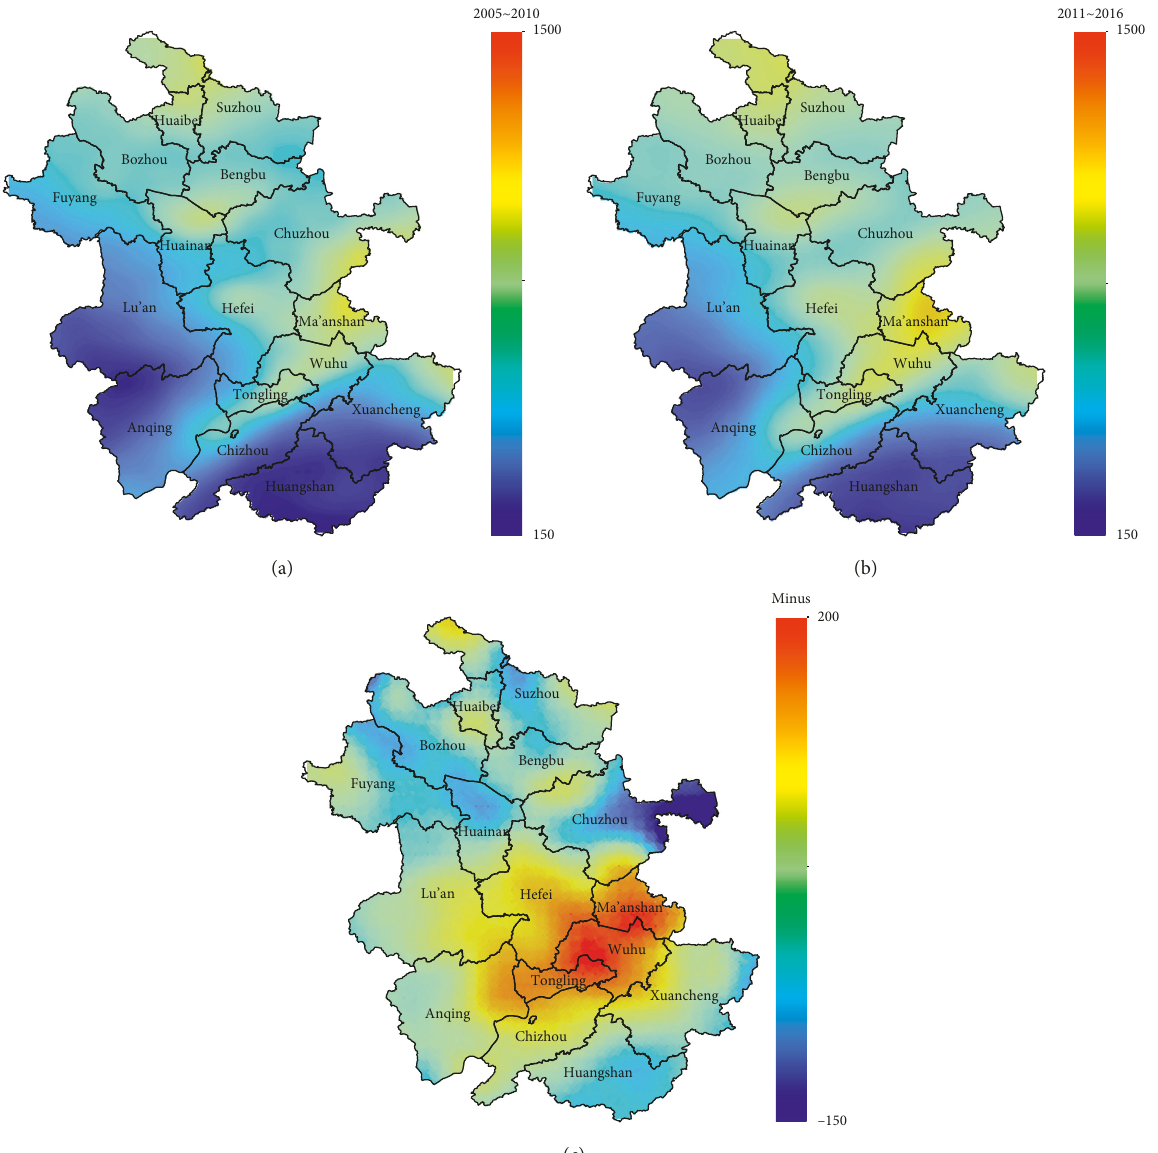
Figure 7: Total of OMI-retrieved vertical column densities ( 10 15 molec./cm 2 ) of NO 2 in Anhui. (a) Total of NO 2 vertical column densities × from 2005 to 2010. (b) Total of NO 2 vertical column densities from 2011 to 2016. (c) Difference in the total of NO 2 vertical column densities between the two periods. The positive values indicate an increasing trend of NO 2 vertical column densities from 2005 to 2016, and vice